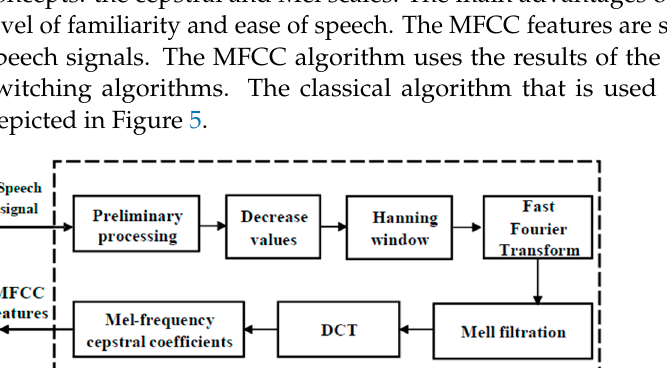
Figure 6. Proposed framework for calculating MFCCs. We consider the execution sequence of the proposed algorithm for the rapid extrac- tion of the function parameters from a speech signal. 4.1. Division into Frames Following preliminary filtering, the speech signal is divided into 16 ms frames. Every frame (except for the first) contains the final 10 ms of the previous frame. This process continues until the end of the signal. In this study, because the sampling rate of the speech signal is 16 kHz, the frame length is N = 256, and the offset length is M = 160. The overlap is 62.5% of the frame length. A coverage of 50% to 75% of the frame length is generally recommended. 4.2. Hanning Window and Decreasing Values A Hanning window size of 1D was used. The Hanning window is also called the raised cosine window. The Hanning window can be thought of as the sum of the fre- quency spectrum of three rectangular time windows. It can use the side lobes to cancel each other out, eliminating high-frequency interference and energy leakage. Hanning windows are very useful window functions. A weight box is used to reduce distortion and smooth the individual frames. The floating signal that is examined in this study consists of a dense tone. The magnitude of the flat tone is determined by the magnitude of the pure tone at frequency f, which is filtered through the Hanning window. A critical aspect of this window is that it sets the borders of the frames to zero. In this case, the short energies can be calculated while passing through the window, and they